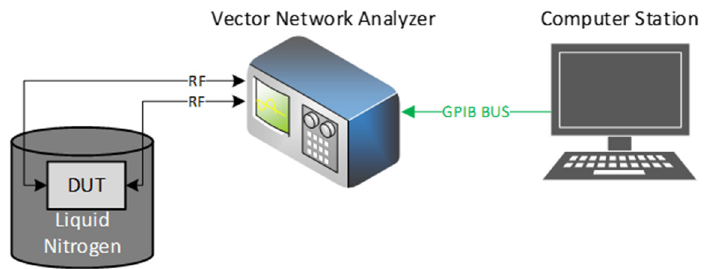
Figure A1. Illustration of the S-Parameter measurement setup.